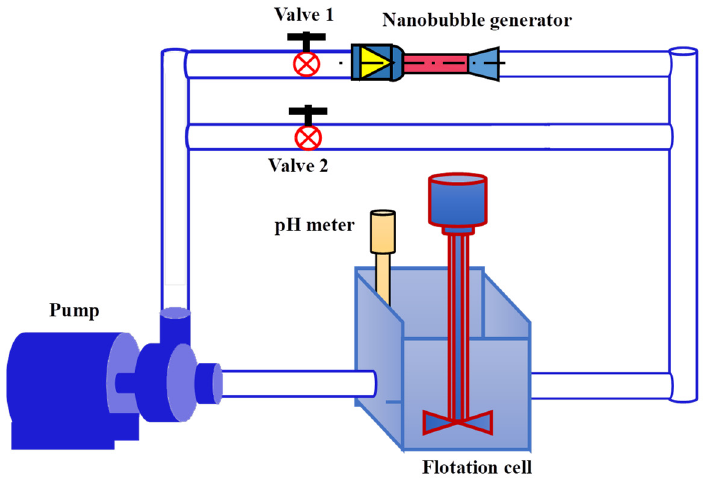
Figure 2. The nanobubble flotation system used in this study.